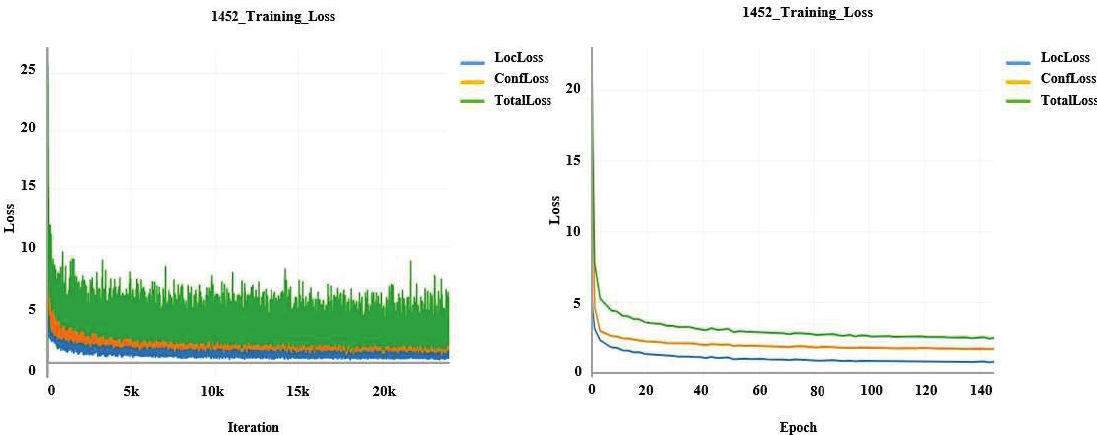
Figure 10. Variation in loss value for floor garbage detection.